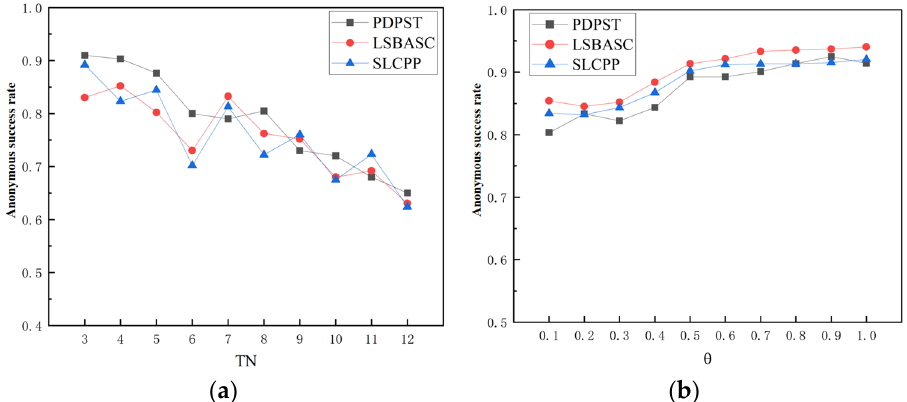
Figure 15. Anonymous success rate: ( a ) variation in anonymity success rate with ( ε = 0.5); ( b ) variation in anonymity success rate with (TN = 10).